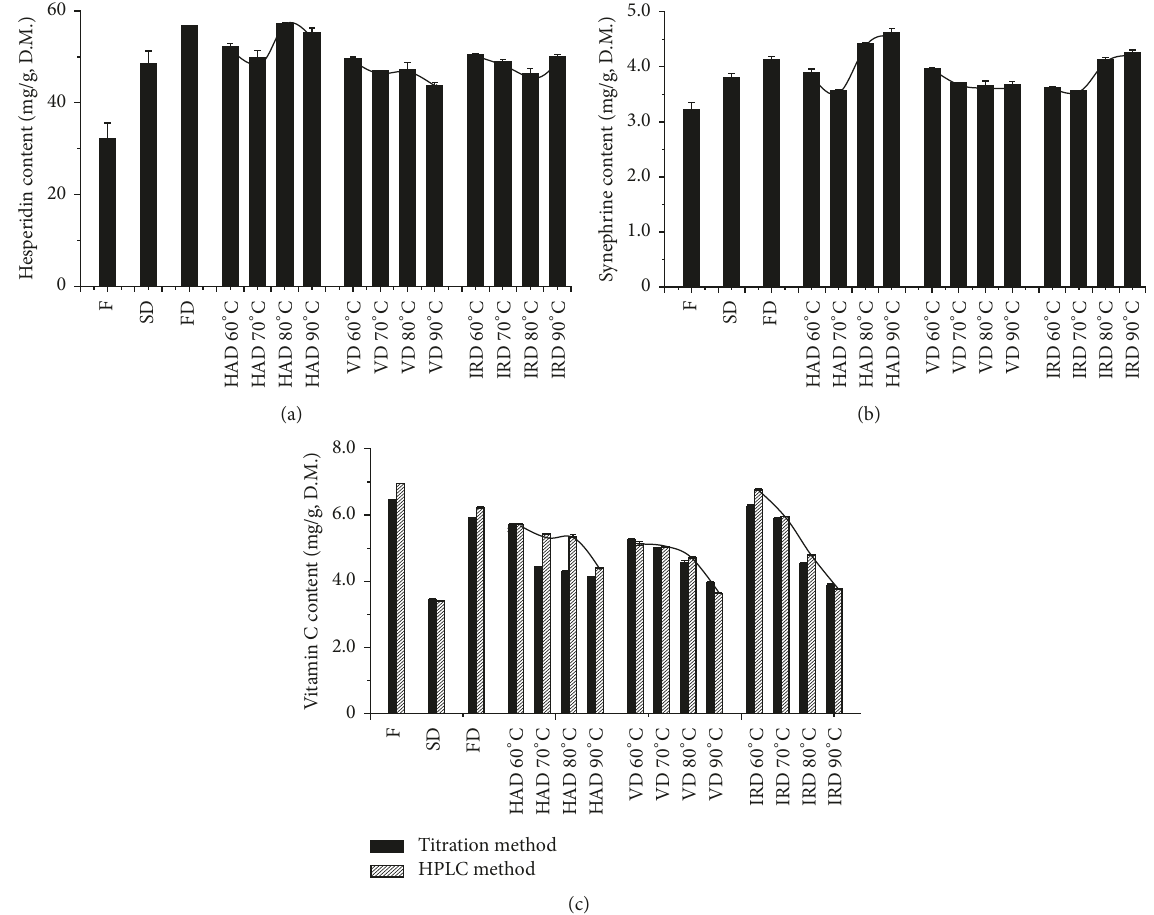
Figure 4: The content variation of hesperidin (a), synephrine (b), and vitamin C (c) in tangerine peels dried by different drying methods.